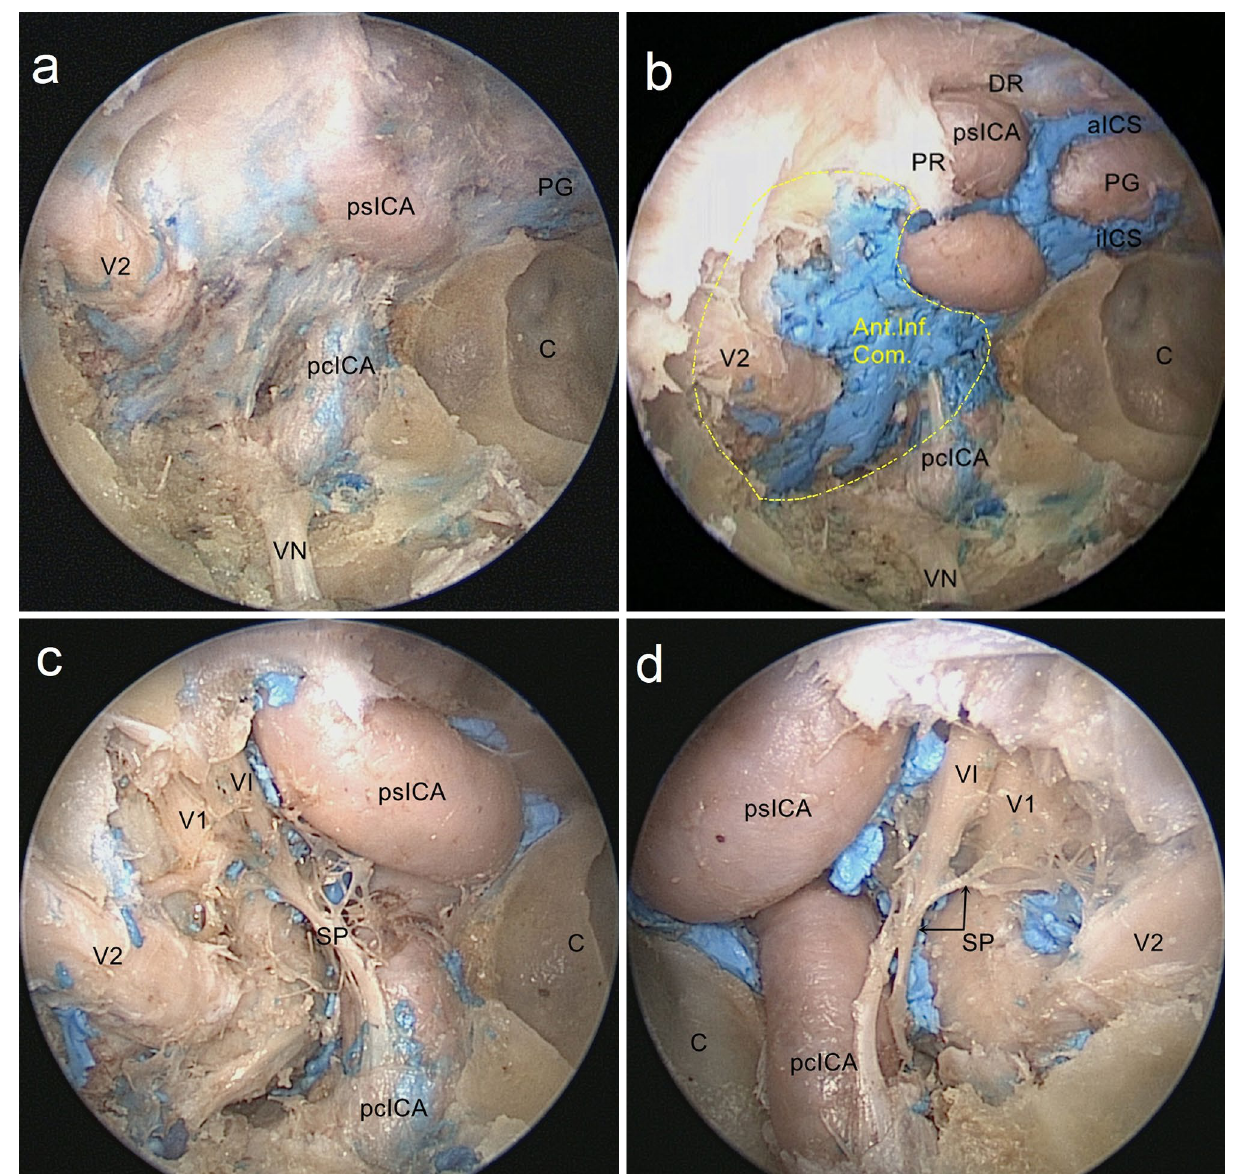
Figure 6. Endoscopic view of the anteroinferior compartment. ( a ) The nasal mucosa is bilaterally elevated from the vomer along the inferior wall of the sphenoid sinus up to identify the Vidian nerve. ( b ) The anteroinferior compartment of the CS is shaped like boat’s bow (the yellow dotted line). ( c ) The sympathetic plexus is in this compartment around the ICA as it travels from the psICA to the ihsICA. ( d ) The sympathetic nerve fibers leave the internal carotid artery (ICA) and then join the abducens nerve and the first trigeminal division. psICA parasellar segment of the ICA, pcICA paraclival segment of the ICA, PG pituitary gland, C clivus, DR distal ring, PR proximal ring, VN Vidian nerve, aICS anterior intercavernous sinus, iICS inferior intercavernous sinus, V1 ophthalmic branch of the trigeminal nerve, V2 maxillary branch of the trigeminal nerve, VI abducens nerve, SP sympathetic plexus, Ant.Inf.Com. anteroinferior compartment of the Stage 4: Exposure of posterosuperior and lateral compartments of the CS venous spaces. The oculomotor, trochlear, ophthalmic (first trigeminal division), and maxillary (second trigeminal division) nerves are embedded in the reticularis membrane forming the lateral compartment of the CS; the abducens nerve, the intracavernous carotid artery, and the surrounding sympathetic plexus have a true intracavernous course. The oculomotor nerve, trochlear nerve, the first division of the trigeminal nerve, and abducens nerve formed a nerve bundle at the superior orbital fissure. Gentle medial mobilization of the ICA genu is required to gain access to the lateral compartment of the CS venous. The lateral compartment is lateral to the anterior vertical psICA and medial to the CS lateral wall. It includes ILT and the 4 triangles (the supratrochlear, infratrochlear, anteromedial, and anterolateral triangles).